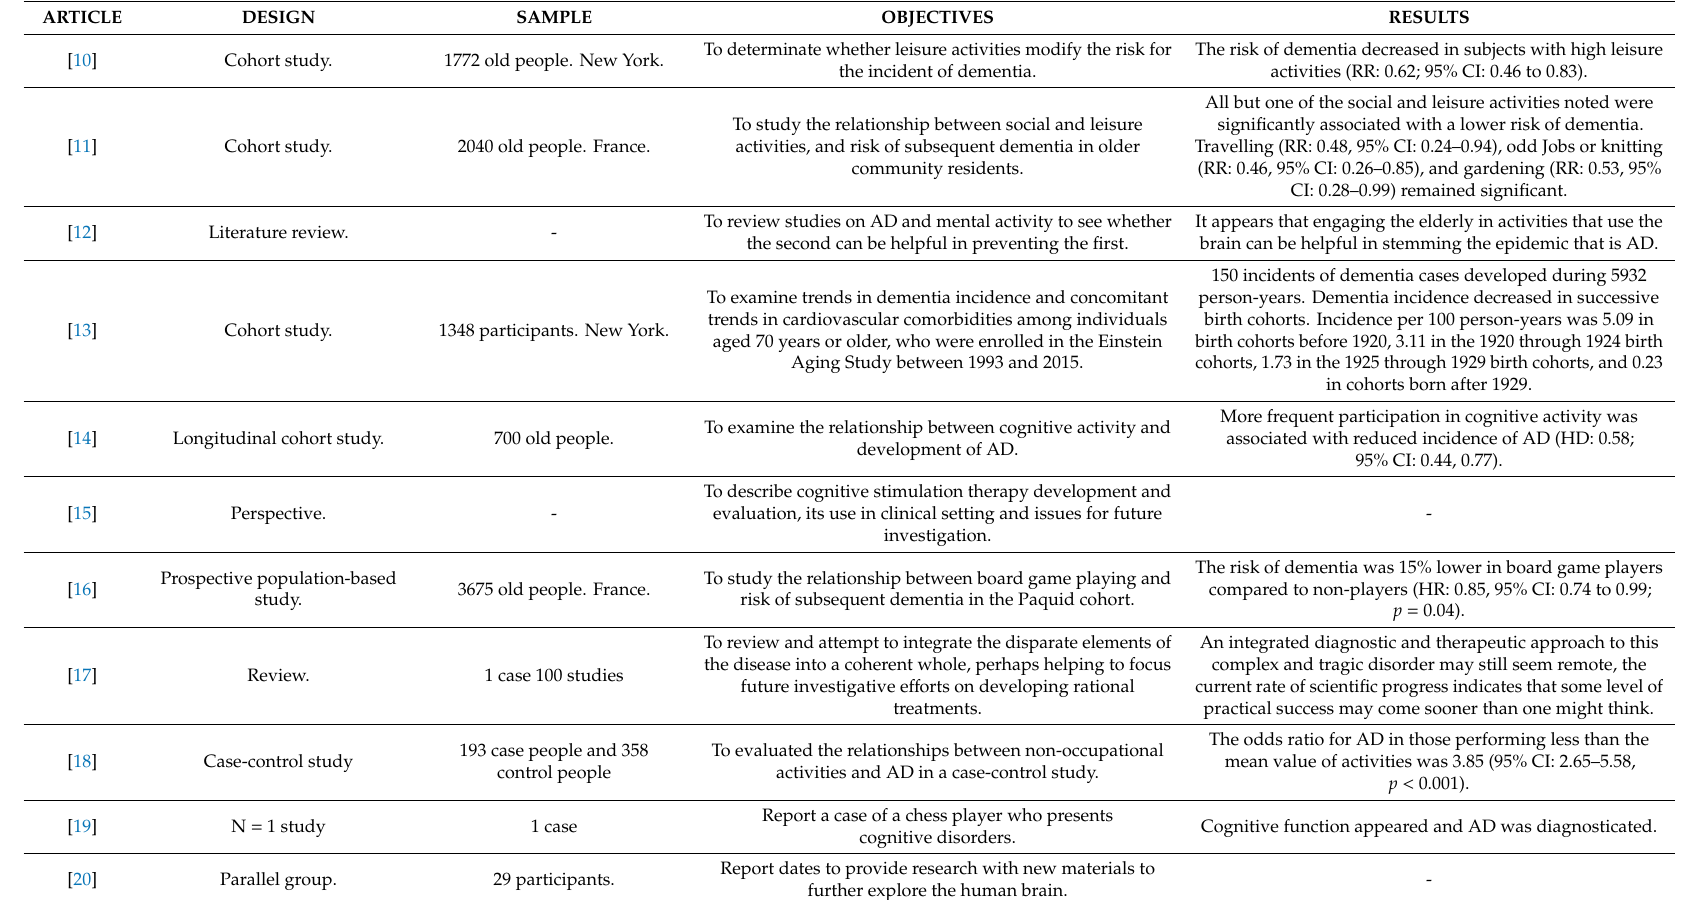
Table 2. Summary of the studies